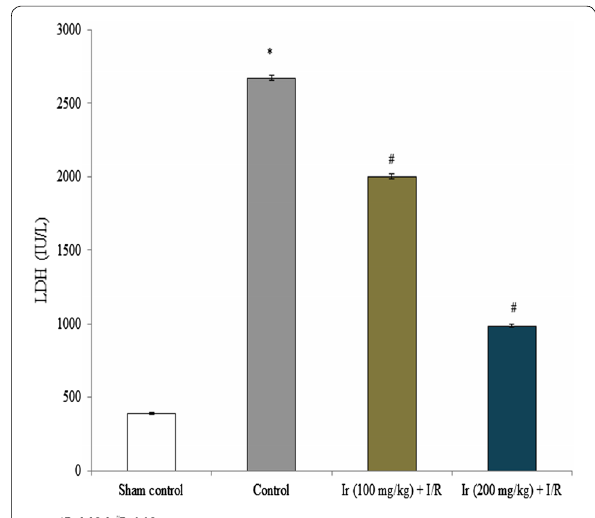
Fig. 3 Ir attenuated serum ALT enzyme level. Values are expressed IU/L. Results are shown mean with SEM. N